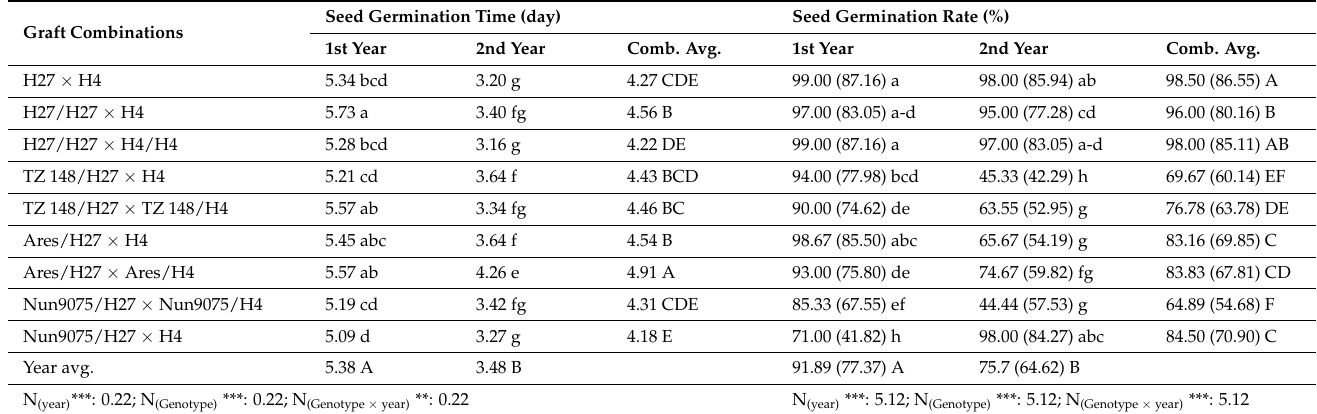
Table 10. Seed germination time and rate of different graft combinations in both